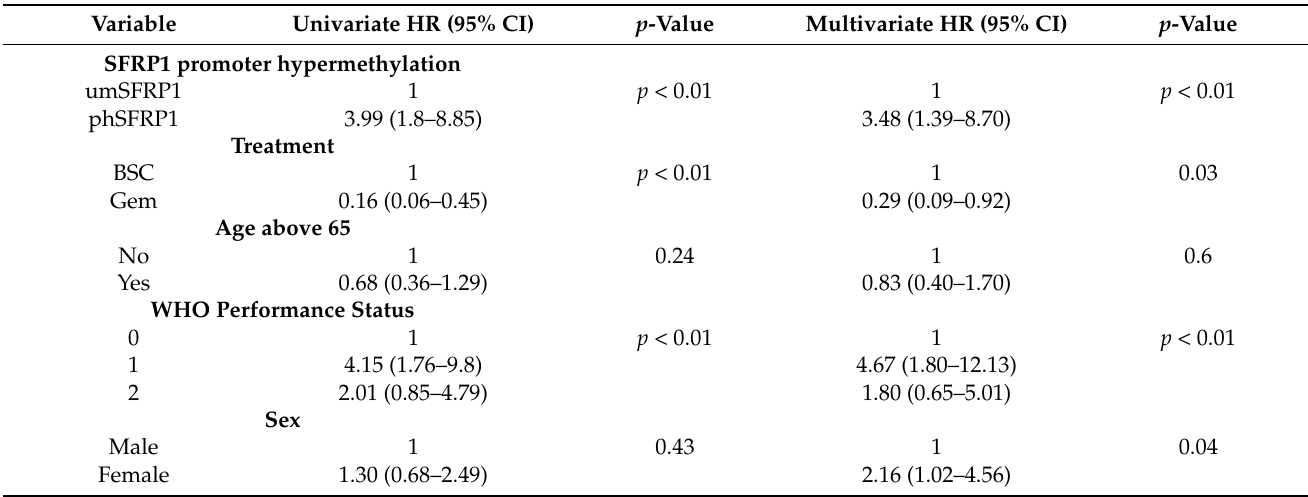
Table 2. Univariate and multivariate Cox regression analysis in patients from the discovery